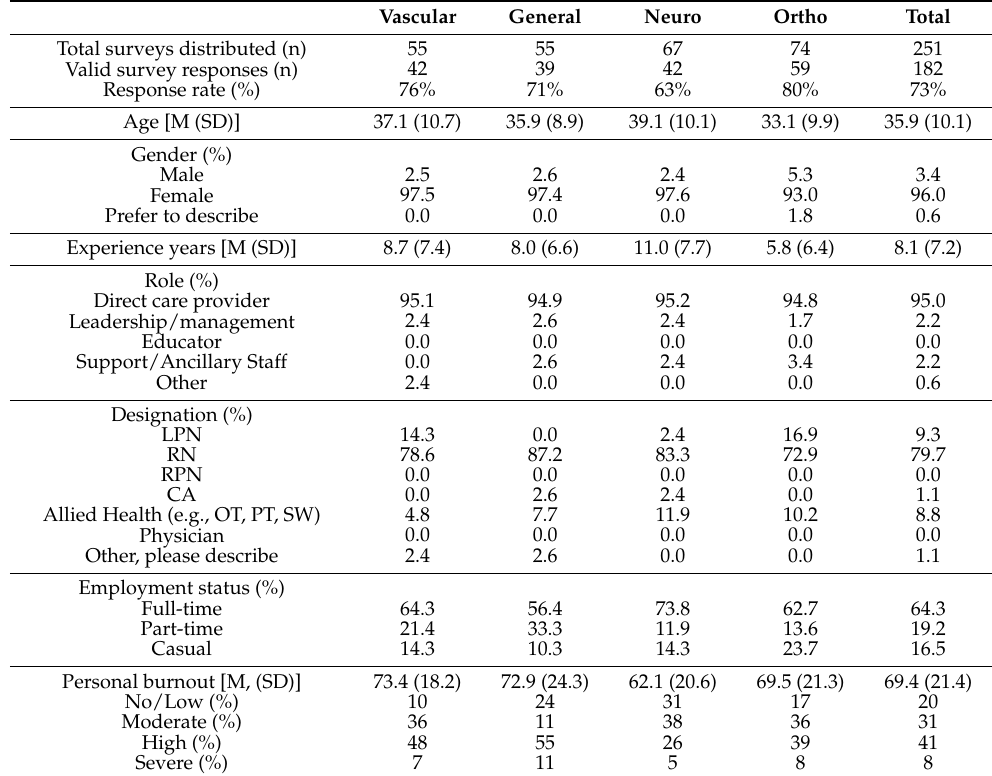
Table 2. Overall and Area-Specific Survey Respondent Characteristics and